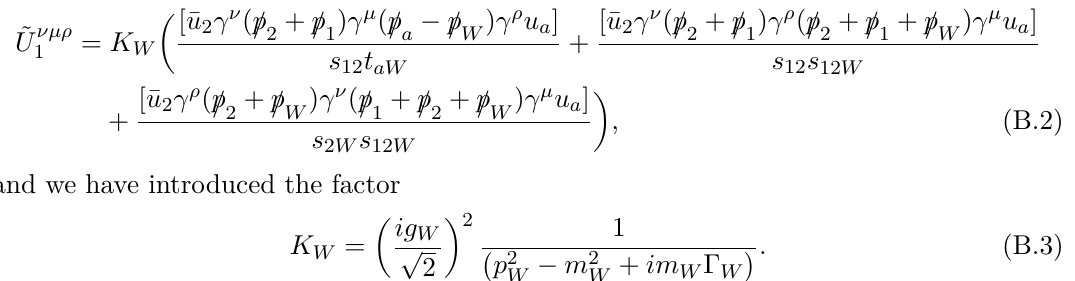
Figure 19. Examples of each of the four categories of Feynman diagram which contribute at leading-order: (a) where the gluon and W boson are emitted from the same quark line and the gluon comes after the t -channel propagator, (b) where the gluon and W boson are emitted from the same quark line and the gluon comes before the t -channel proagator, (c) the gluon is emitted from the t -channel gluon and in (d) the gluon is emitted from the b – 3 quark line.